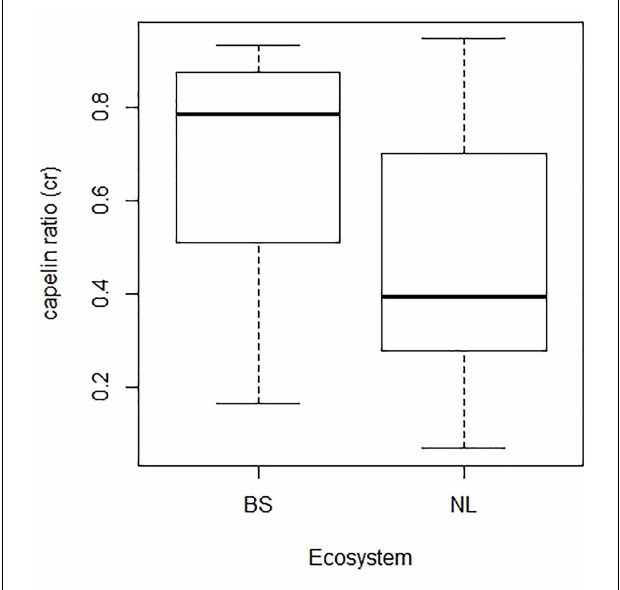
FIGURE 7 | Box plots of the annual capelin ratios (i.e., the fraction of capelin in relation to total food availability for cod derived from model results) in the Barents Sea (BS) and Newfoundland-Labrador shelves (NL) ecosystems. These ratios correspond to the model assuming a and e as common parameters to both stocks, and can be interpreted a coarse approximation to the proportion of energy that cod derives from capelin in each